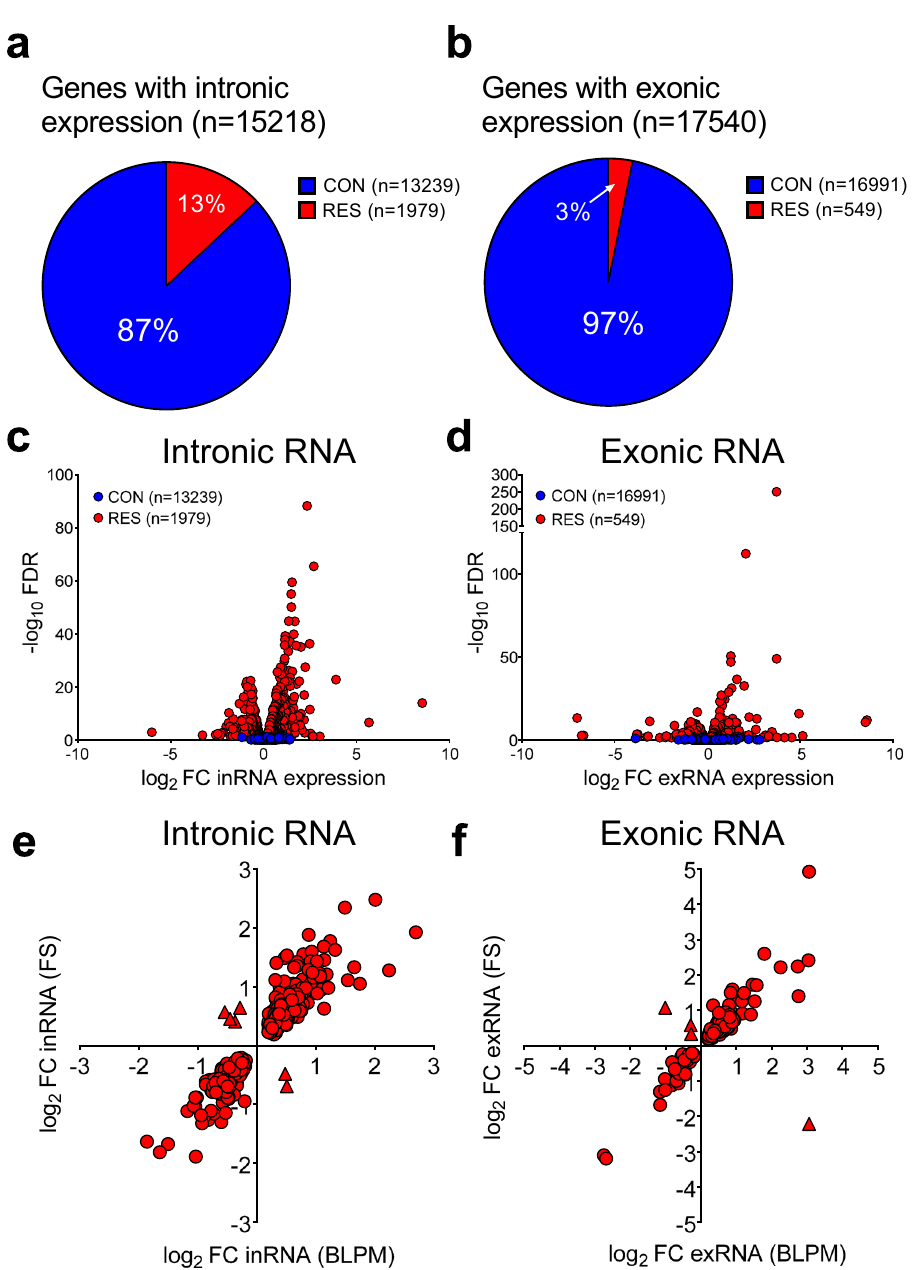
Fig. 4 Differential expression analysis of hippocampal RNA. Differential expression analysis was conducted on intronic RNA (inRNA; a , c , e ) and exonic RNA (exRNA; b , d , f ) under different physiological conditions compared with BLAM conditions. Differential expression (edgeR) analysis identi fi ed genes of which the intronic or exonic expression was upregulated or downregulated (referred to as responsive (RES)) or remained stable (constant (CON)) following acute stress or the circadian rise. a , b Pie charts displaying the proportion of genes of which the intronic ( a ) and exonic ( b ) RNA expression is signi fi cantly altered in response to stress or circadian in fl uences (RES) or genes of which the expression does not change between conditions (CON). c , d Volcano plots showing the fold-change in RNA expression (log 2 FC) versus the statistical signi fi cance of the change (-log 10 FDR). RES genes are shown in red circles whereas CON genes are depicted in blue circles. c Intronic RNA, d exonic RNA). e , f Scatter plots displaying the highly signi fi cant Spearman rank correlations between changes in gene expression following stress (FS) and those under circadian in fl uences (BLPM). Intronic ( e ); n = 470, r s = 0.9295, p < 0.0001; Exonic ( f ); n = 171, r s = 0.8198, p < 0.0001. Genes responding in the same direction to both stress and the circadian drive are depicted by red circles, whilst genes showed opposing responses to acute stress and the circadian drive are depicted by red triangles ( e , Intronic RNA; f , exonic RNA). Source data are provided in the Source Data